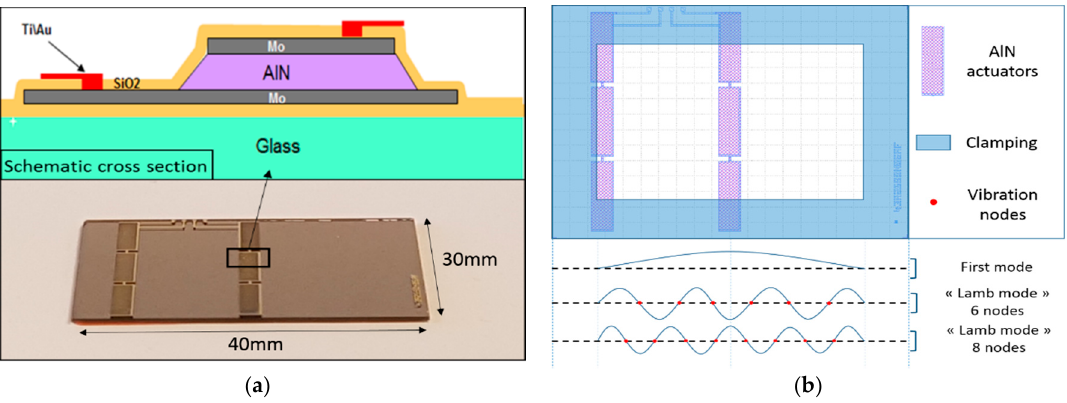
Figure 1. ( a ) AlN-on-glass schematic technological stack cross section and photography; ( b ) Design of the 40 mm × 30 mm glass plate and schematic cross section of resonant mode shapes.